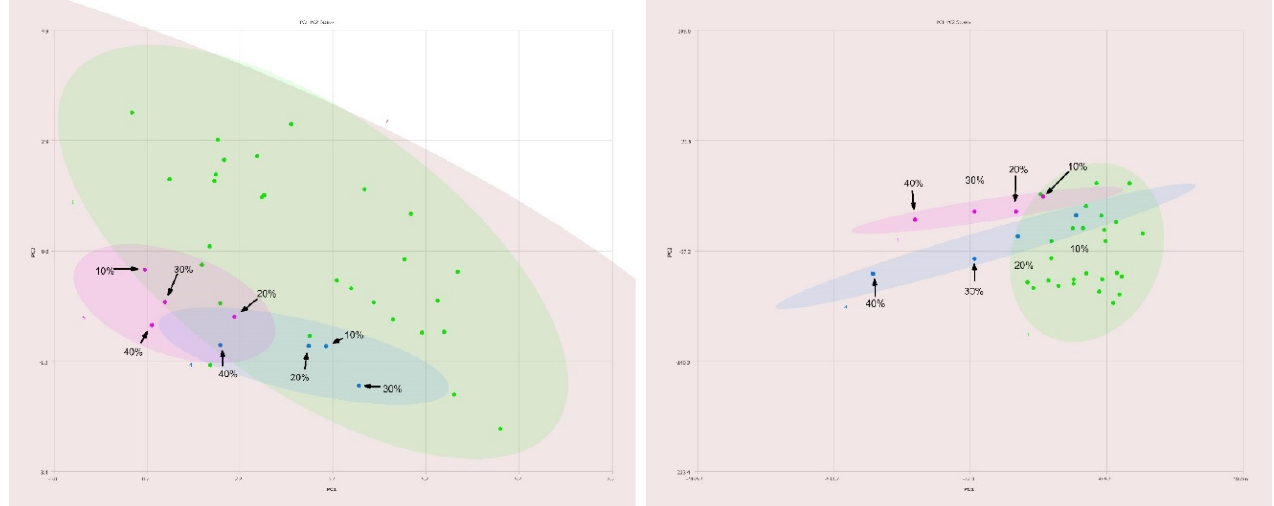
Figure 2. Comparison of PC1–PC2 plots of 400 MHz 1H NMR spectra of pure olive oils (green), safflower oil adulterated olive oil (magenta) and sunflower oil adulterated olive oil (blue) showing the differences between traditional normalization ( left ) and normalization to ω -3 fatty acids ( right ).